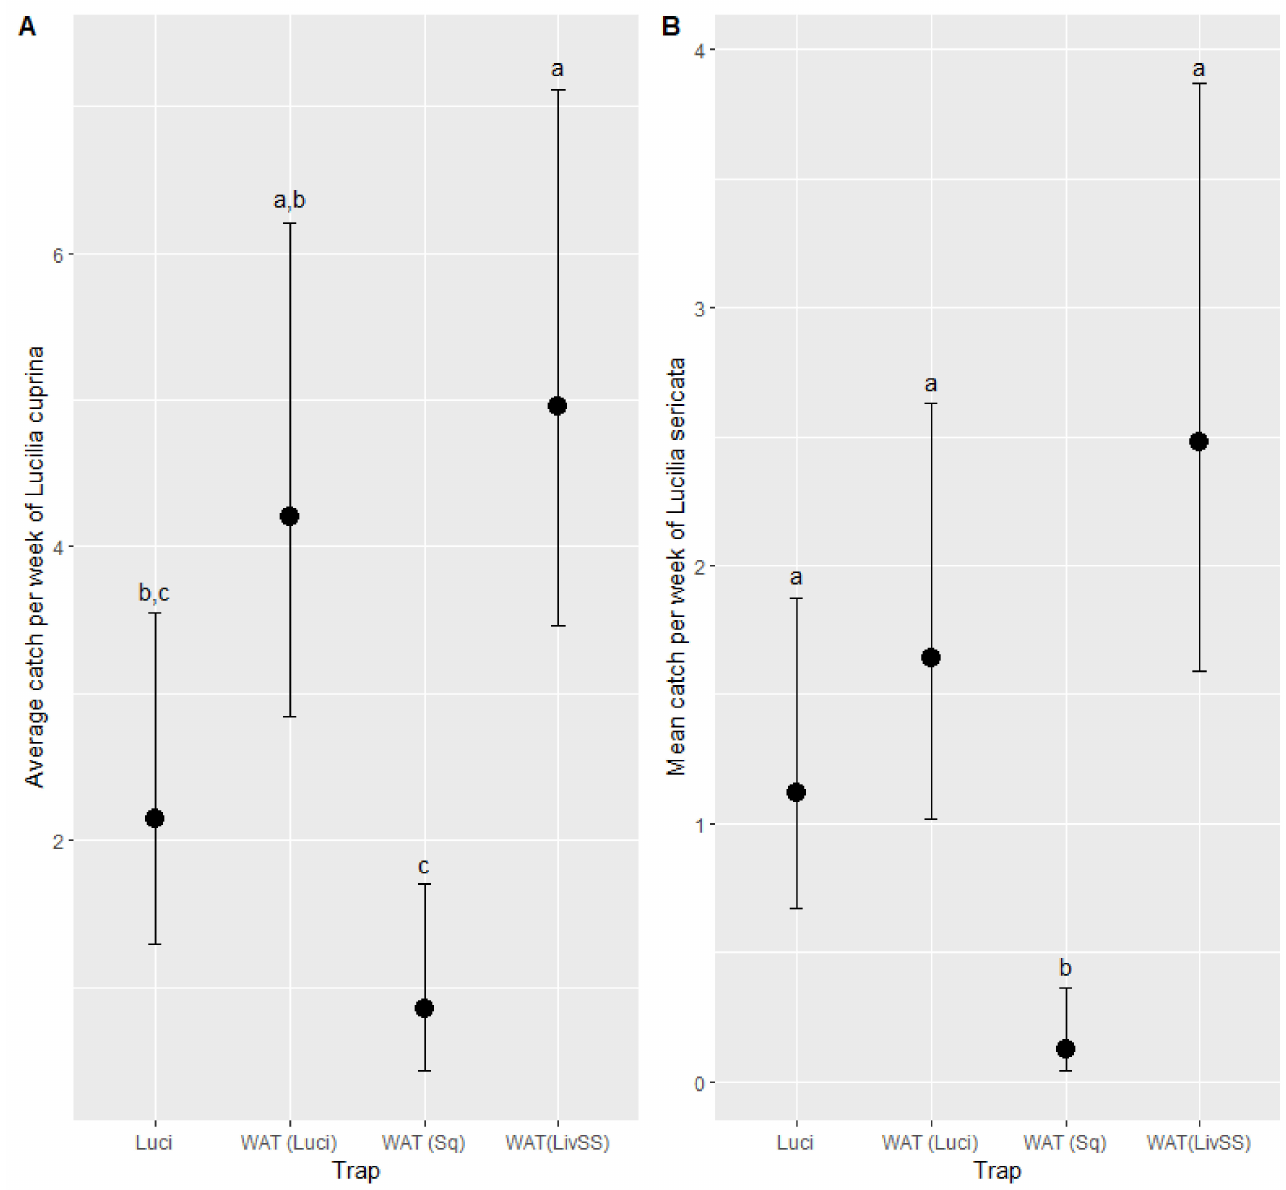
Figure 9. The estimated mean catch per week of Lucilia cuprina ( A ) and Lucilia sericata ( B ) by each trap type adjusting for the effect of maximum temperature. Trap types with differing letters (a, b, and c), within target species, are significantly different based on a Tukey comparison of least square means ± standard error ( p < 0.05). LuciTrap with LuciLure A, B and C (Luci); Western Australian Trap with squid (WAT (Sq)), Western Australian Trap with LuciLure A, B and C (WAT (Luci)); and Western Australian Trap with sheep liver and sodium sulphide (WAT